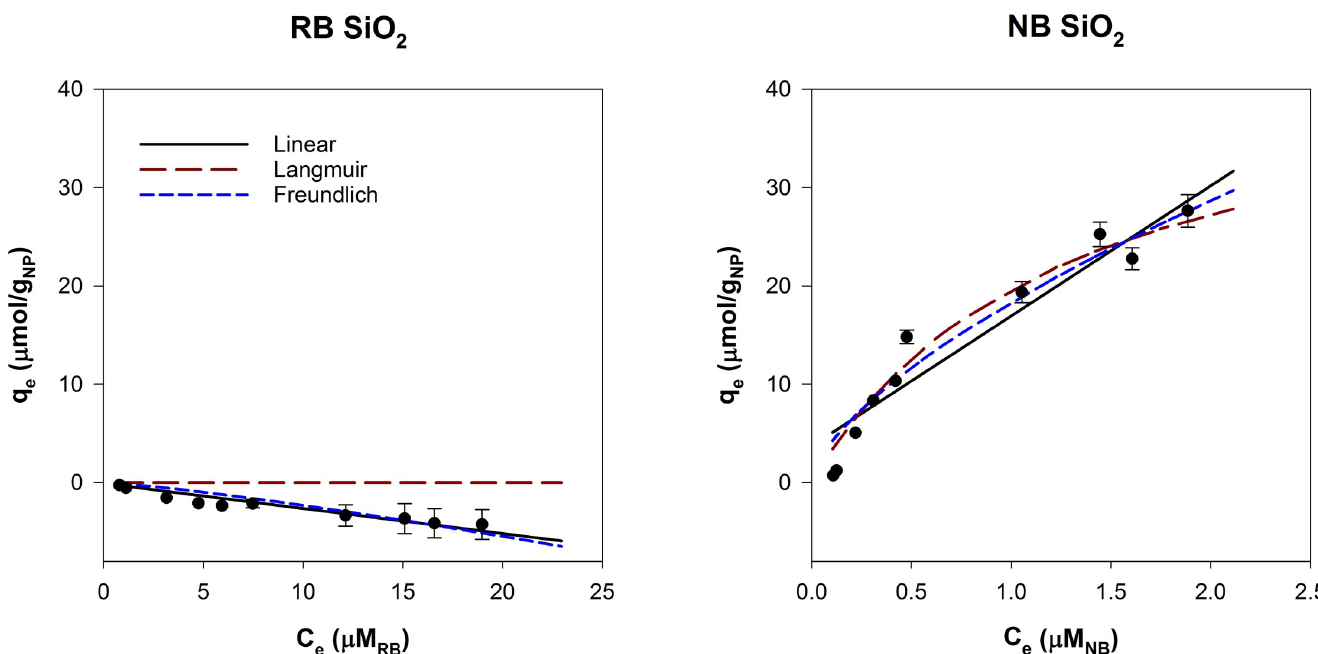
Fig 5. Adsorption isotherms for 500 mg/L SiO 2 NPs with Rose Bengal and Nile Blue, modeled with linear, Langmuir and Freundlich adsorption models.